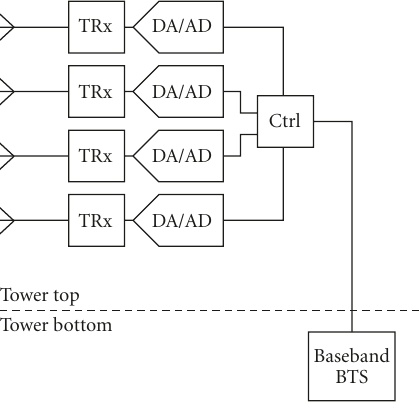
Figure 1: The hardware division between tower top and bottom for the tower-top BTS.